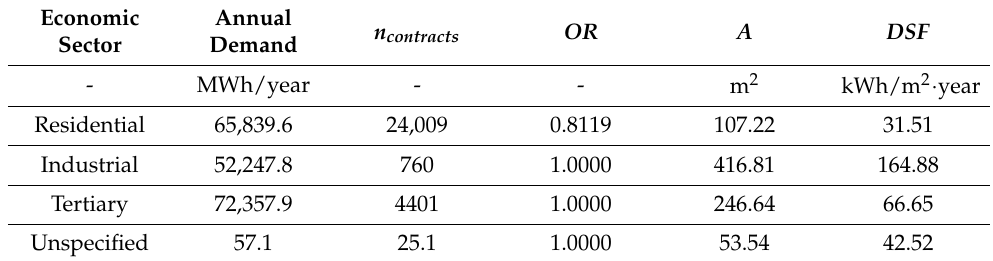
Table 2. DSF values obtained through Equation (1) for each economic